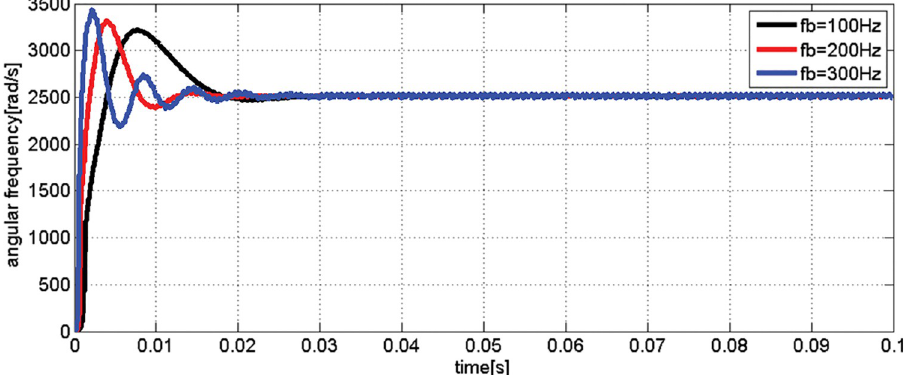
Fig 6. Simulation results of ω g under three